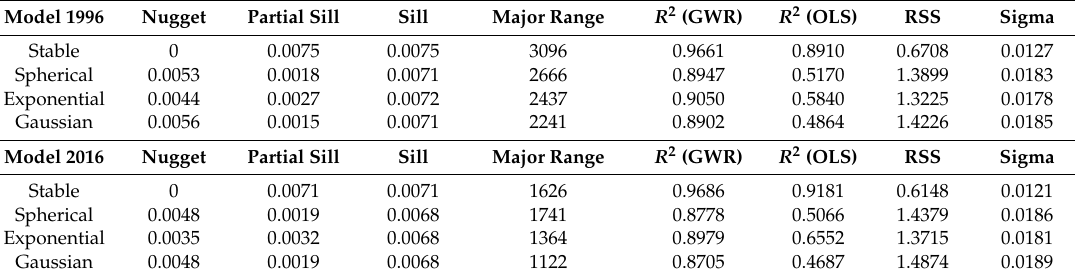
Table 3. Semi-variance modeling parameters for fire inappropriateness models of 1996 and 2016 1